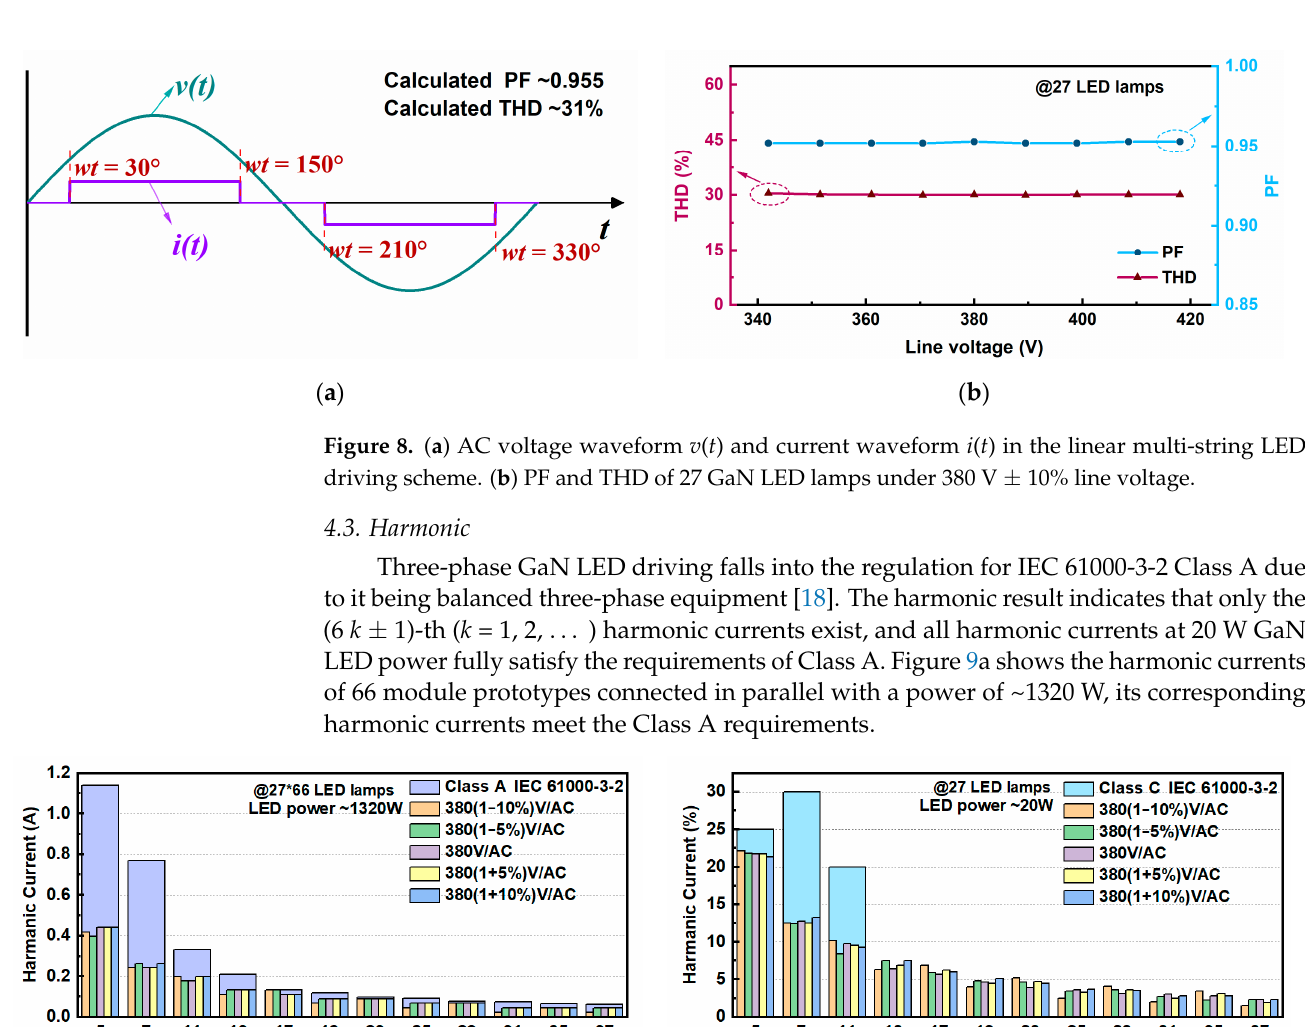
( d ) Figure 7. ( a ) LED power, ( b ) driving efficiency, ( c ) optimization goal G , and ( d ) driving current in double-string GaN LED driving experiment. 4.2. PF and THD Figure 8a shows the voltage waveform v ( t ) and current waveform i ( t ) of each AC phase in the linear GaN LED driving scheme. Based on the voltage waveform v ( t ) and